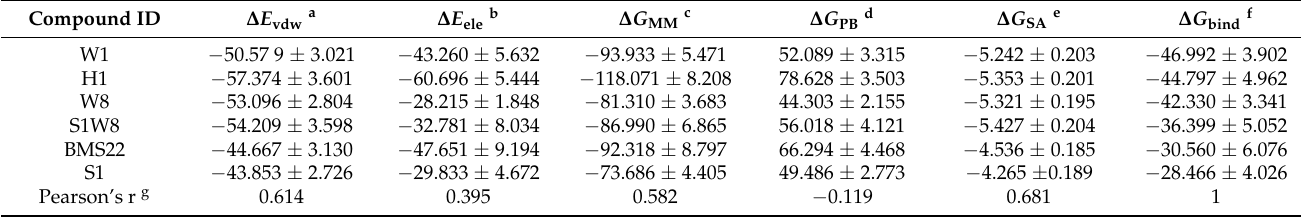
Table 2. Binding free energies and corresponding energy components between the TGF β RI pocket and agents by MM/PBSA during the last 20ns MD